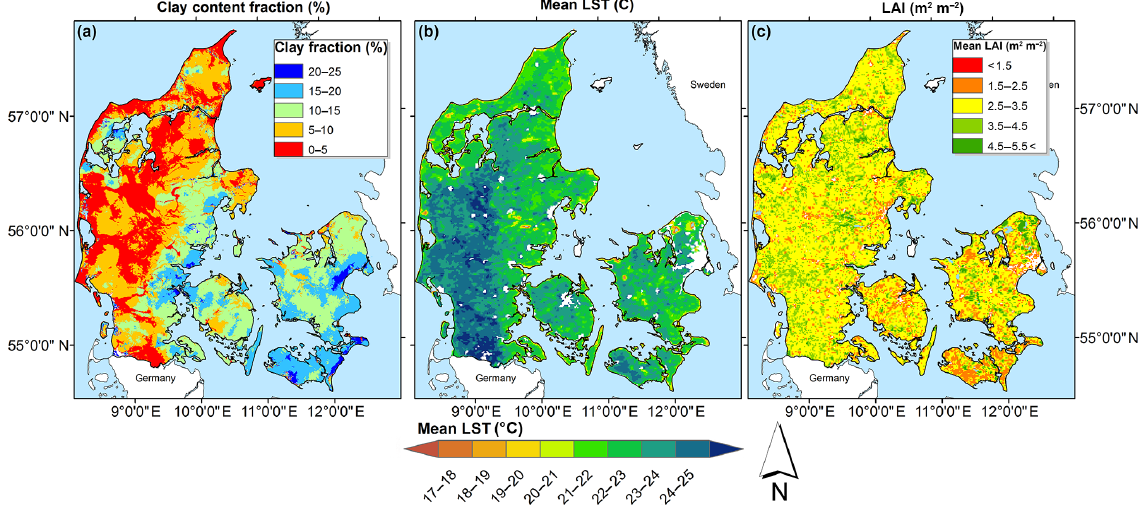
Figure 10. Maps of three different parameters used in this study. Panel (a) shows the clay fraction distribution (%). Panel (b) displays the mean values of LST ( ◦ C) during the growing season and (c) displays the mean values of LAI (m 2 m − 2 ) during the growing season and those used in the TSEB.